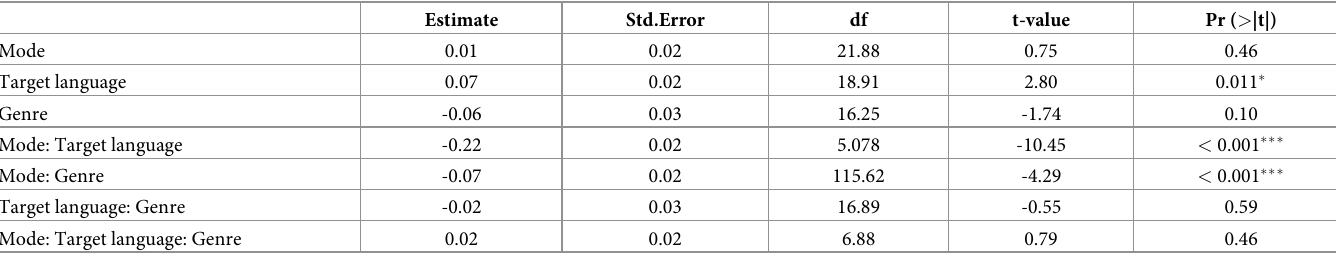
Table 4. Model results for average fixation count in ST.